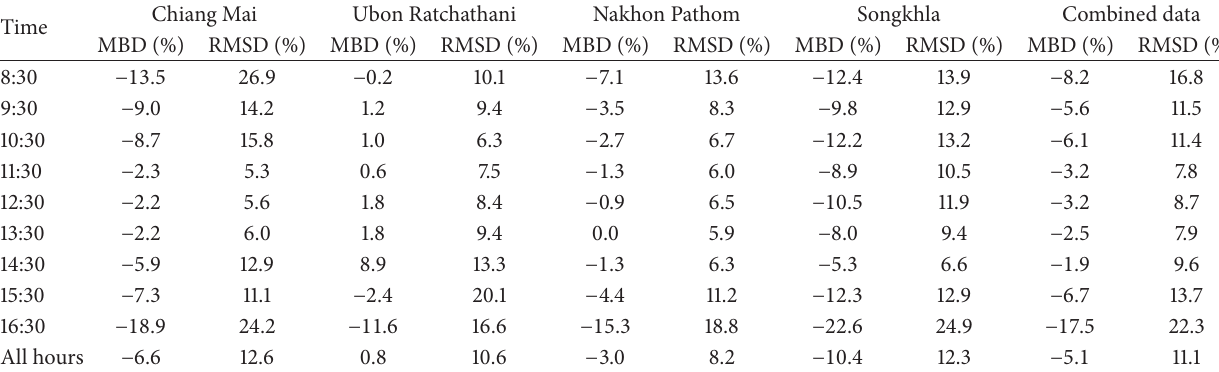
Table 3: Root mean square difference (RMSD) and mean bias difference (MBD) obtained from the comparison between calculated and measured monthly average hourly PAR values. Chiang Mai Ubon Ratchathani Nakhon Pathom Time